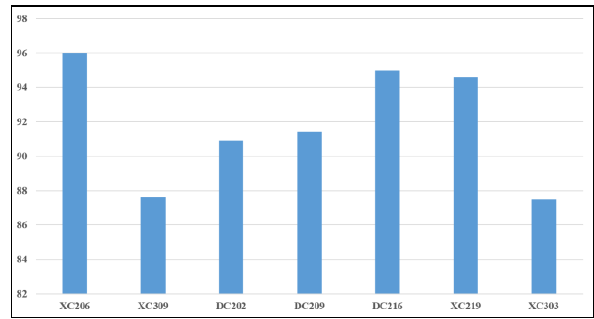
Figure 2 . Statistics of unit achievement quality